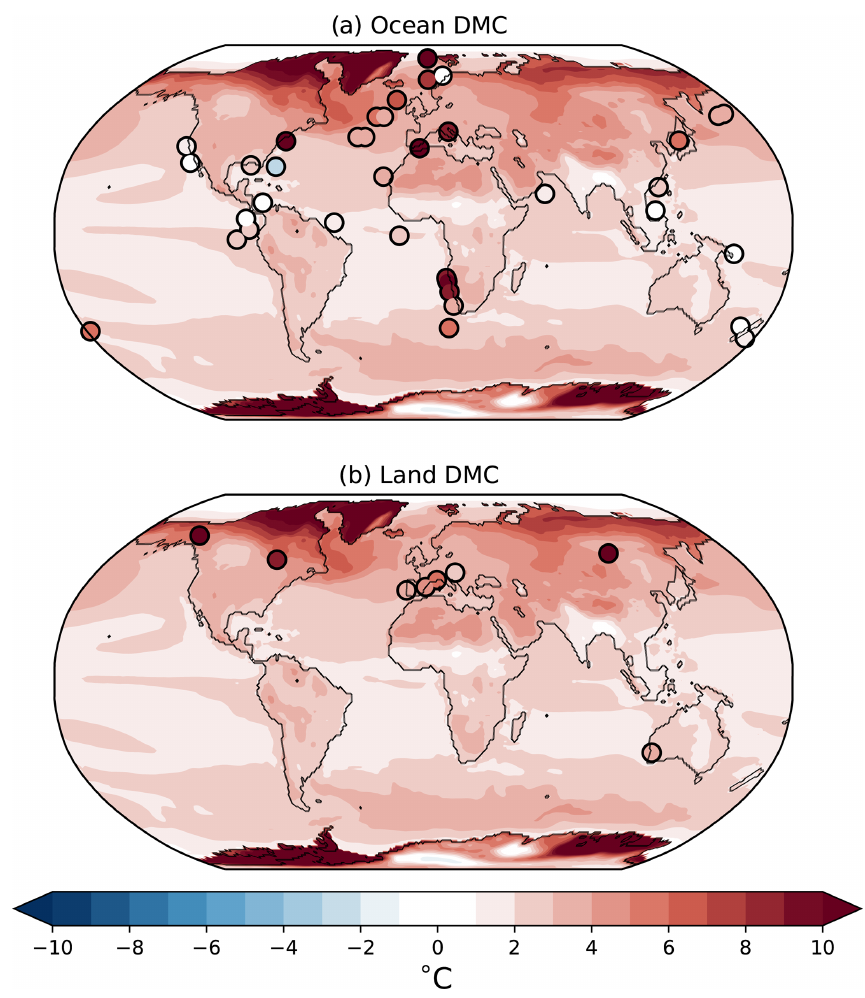
Figure 1. The background colours are multi-model mean results from PlioMIP2 (Haywood et al., 2020). (a) The ocean site data SST anomaly is the difference between the McClymont et al. (2020) dataset and years 1870–1899 of the NOAA Extended Reconstructed Sea Surface Temperature (ERSST) version 5 dataset (Huang et al., 2017). (b) The terrestrial data SAT anomaly is the difference between the KM5c terrestrial dataset and the CRU reanalysis data (CRU TS v 4.04; Harris et al., 2020) averaged over the period